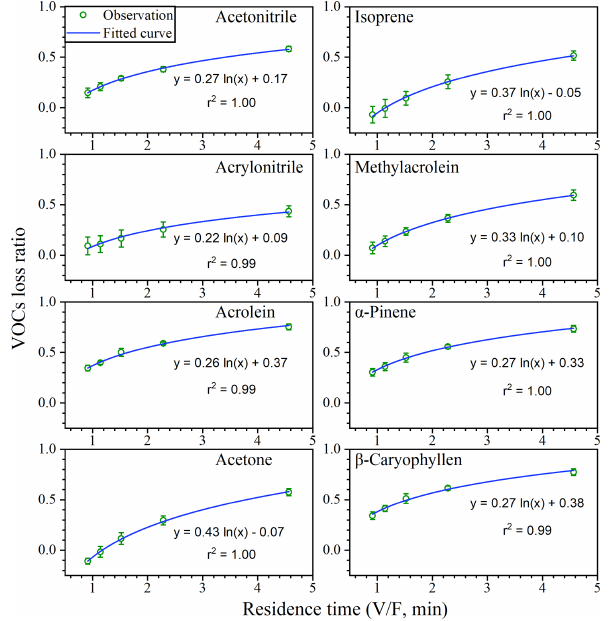
Figure 5. Changes in BVOCs loss ratios (mean ± 1 σ , n = 5) with residence